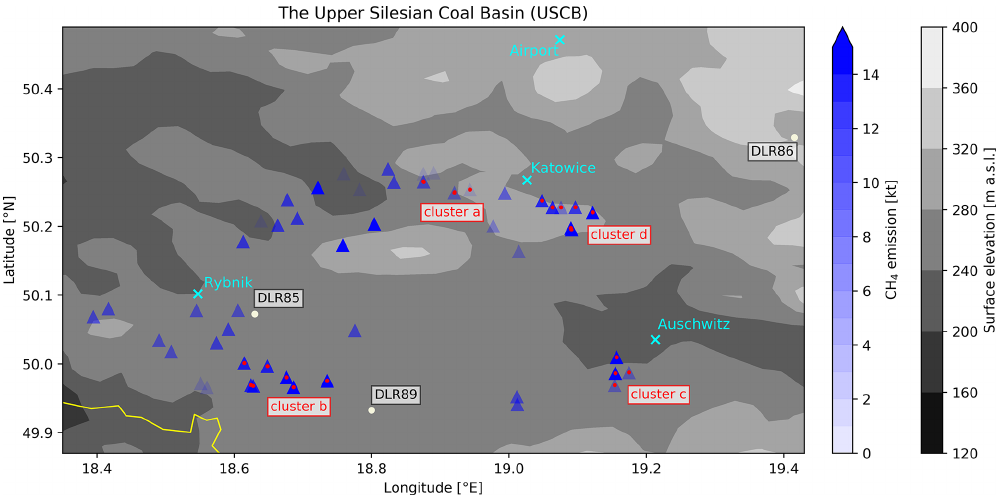
Figure 2. Overview of the active coal mine ventilation shafts in the Upper Silesian Coal Basin (USCB, blueish triangles). Colour intensity indicates the annual CH 4 emission as stated in the CoMet ED v4 inventory for the year 2018. Ventilation shafts filled with a red circle are investigated in this work and grouped in four clusters (see main text and Table 1 for details). Filled white circles give the locations of the three wind lidars deployed during the CoMet campaign (DLR85: 50.07025 ◦ N, 18.6298 ◦ E; at 250ma . s . l . ; DLR86: 50.3292 ◦ N, 19.4155 ◦ E; at 300ma . s . l . ; DLR89: 49.9326 ◦ N, 18.7998 ◦ E; at 270ma . s . l . ). The airport is located north of the mining region. The grey shading indicates the terrain height and the border with the Czech Republic is represented by the solid yellow